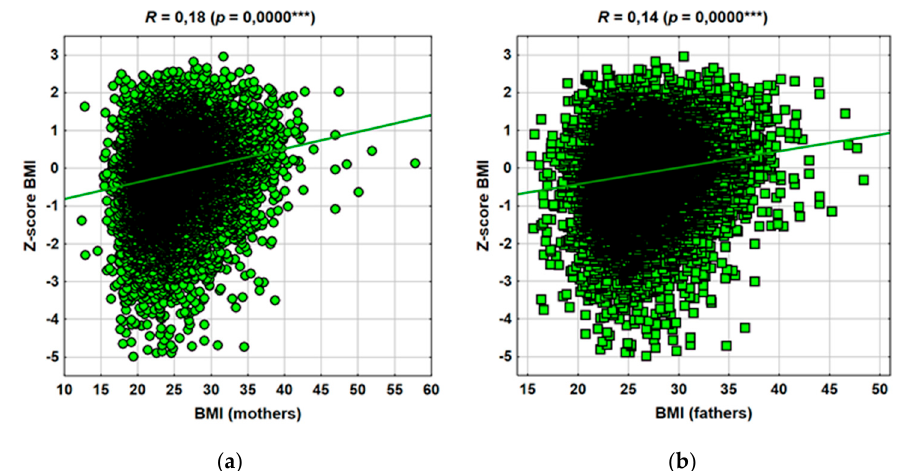
Figure 1. Spearman’s rank correlation between ( a ) mothers’ body mass index (BMI) and ( b ) fathers’ BMI with z-score BMI of children.